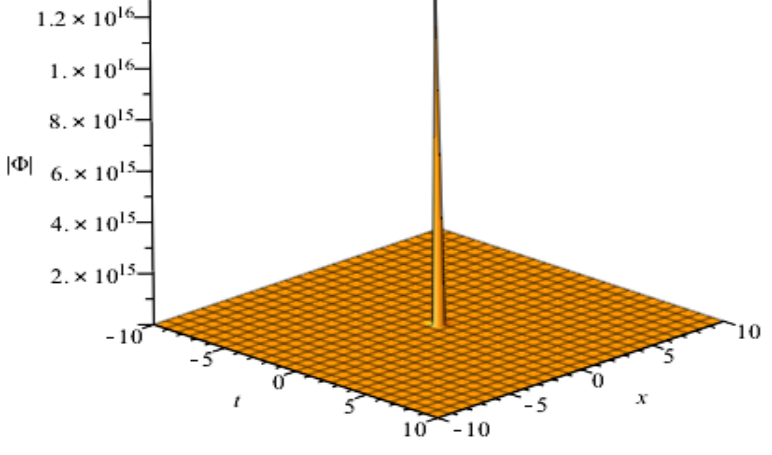
Figure 2. Plot of the singular soliton solution (22) with a = 0.2, b = 0.35, c = − 0.4, δ = 0.5, κ = 0.25, ω = 0.6, σ = 0.35, v = − 0.4743835616, γ = 0.5, and − 10 ≤ x , t ≤